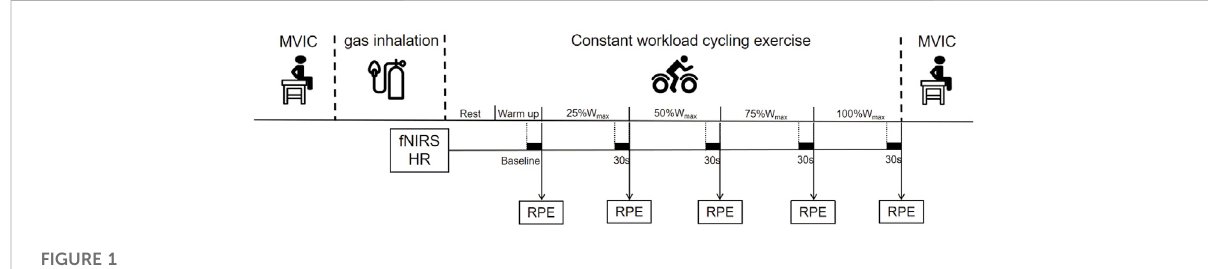
FIGURE 1 Assessment protocol on one visit (Visit 3 or